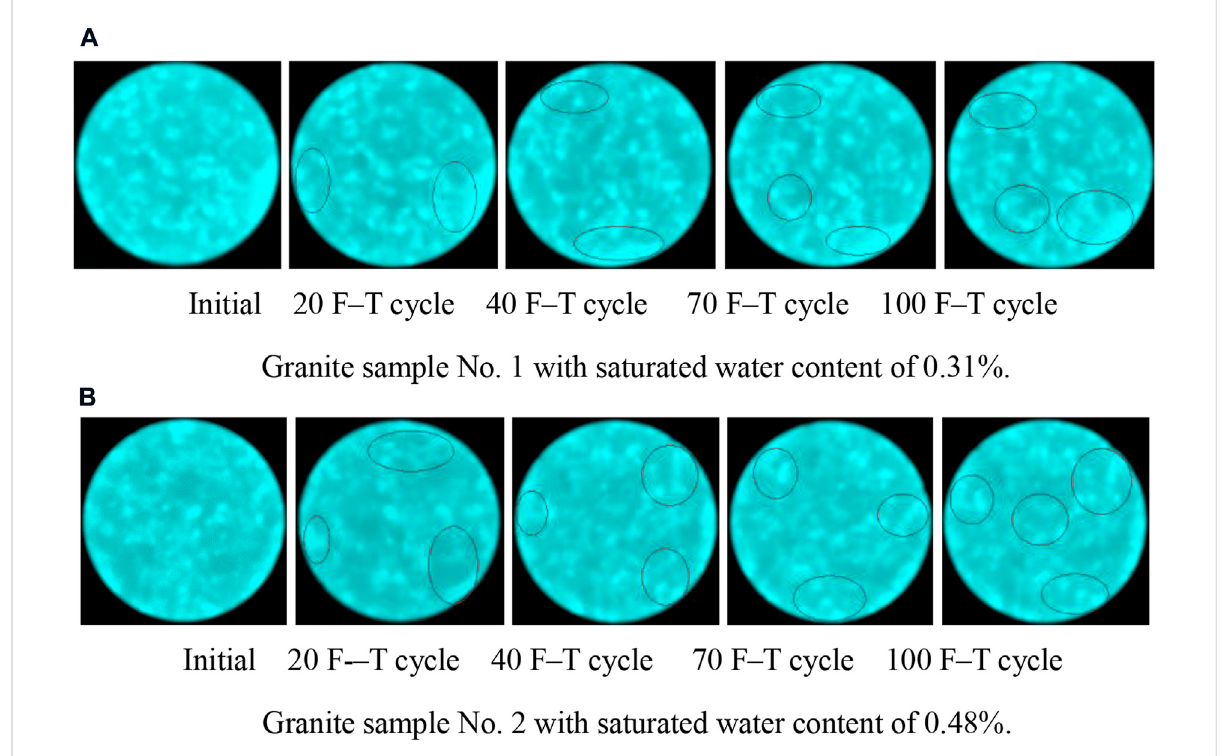
FIGURE 13 CTimagesofthe16thscanninglayer forgranitesamplesunder differentnumbersofF – Tcycles.Initial 20 F – Tcycle40 F – Tcycle70 F – Tcycle